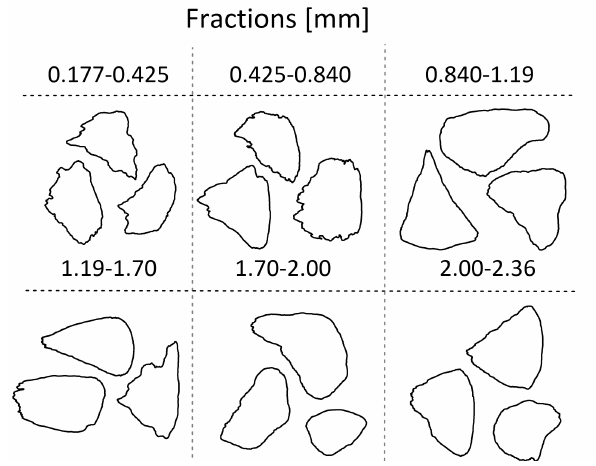
Figure 2. Quantitative comparison of LECA grain shape outline for di ff erent size